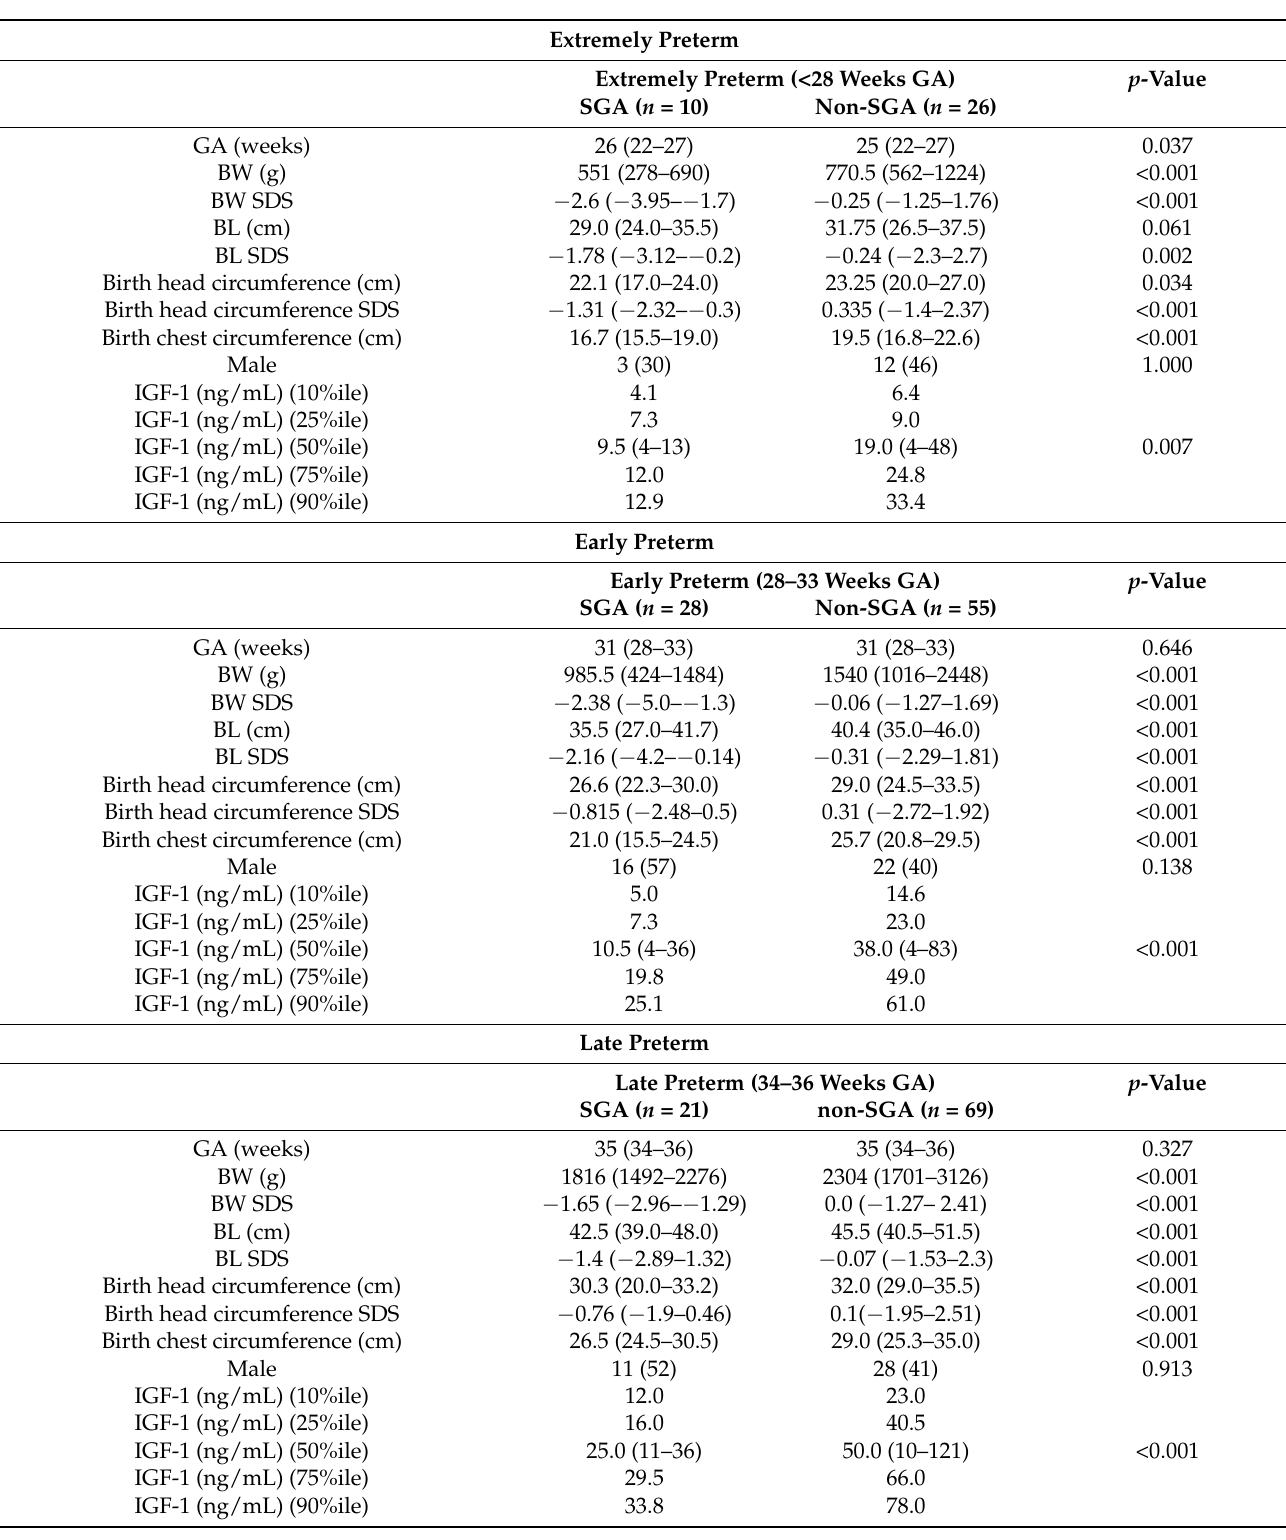
Table 2. Comparison of umbilical cord blood IGF-1 levels between SGA and non-SGA